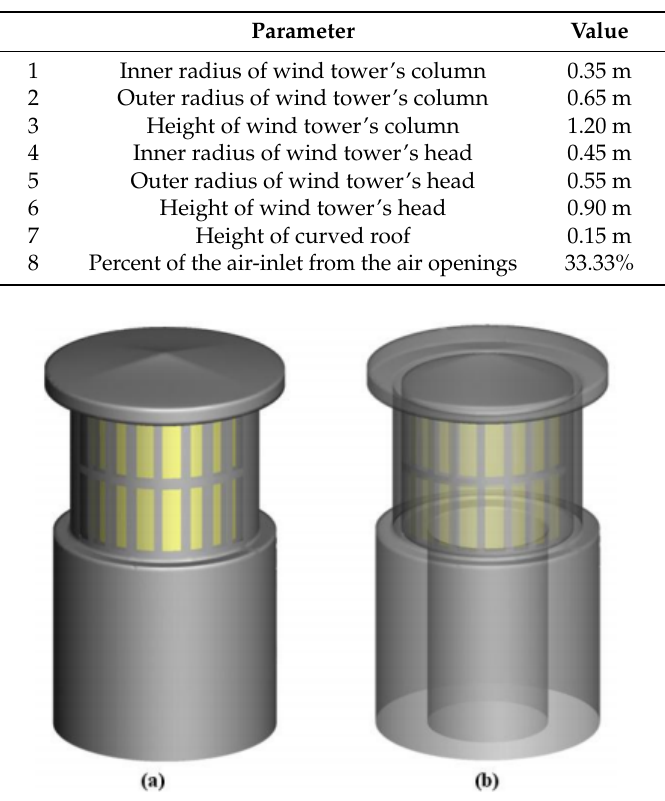
Table 1. Characteristics of the proposed wind tower.